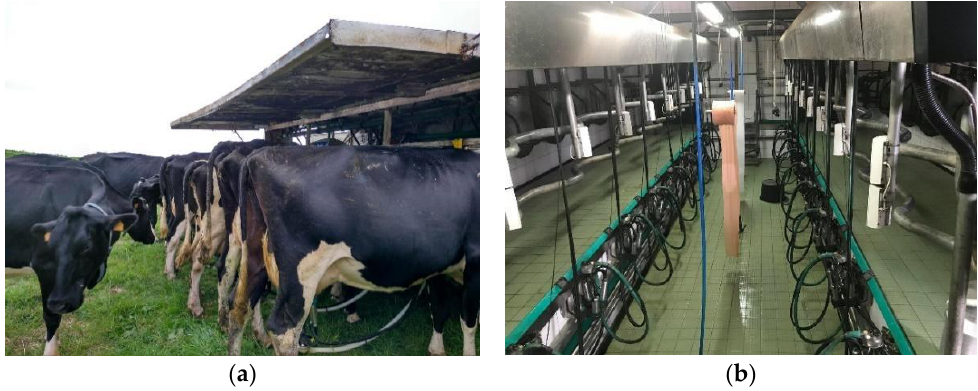
Figure 1. Traditional mobile milking system ( a ) and fixed milking parlors ( b ).